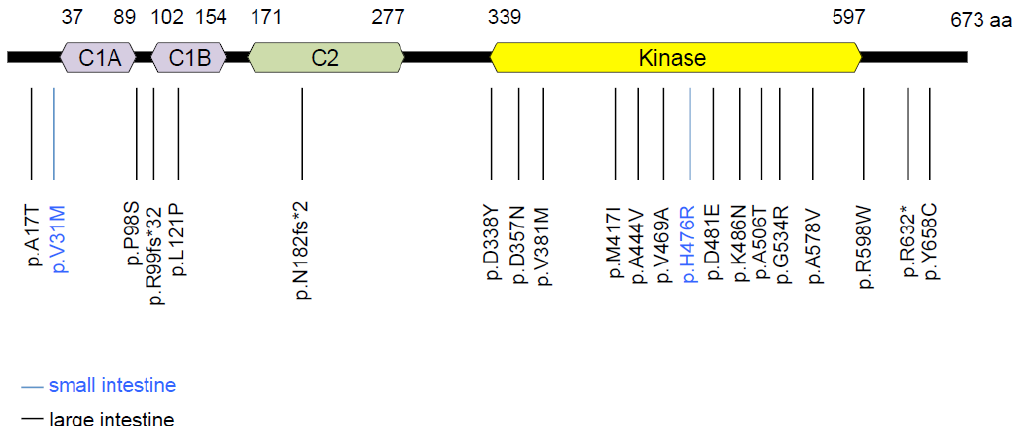
Figure Figure 3. Non- silent PKCα mutations identified in both small intestine and colon tumors. (http://cancer.sanger.ac.uk/cosmic). p: protein sequence as the reference sequence; fs: shift of the reading frame. *: insertion of a stop codon.